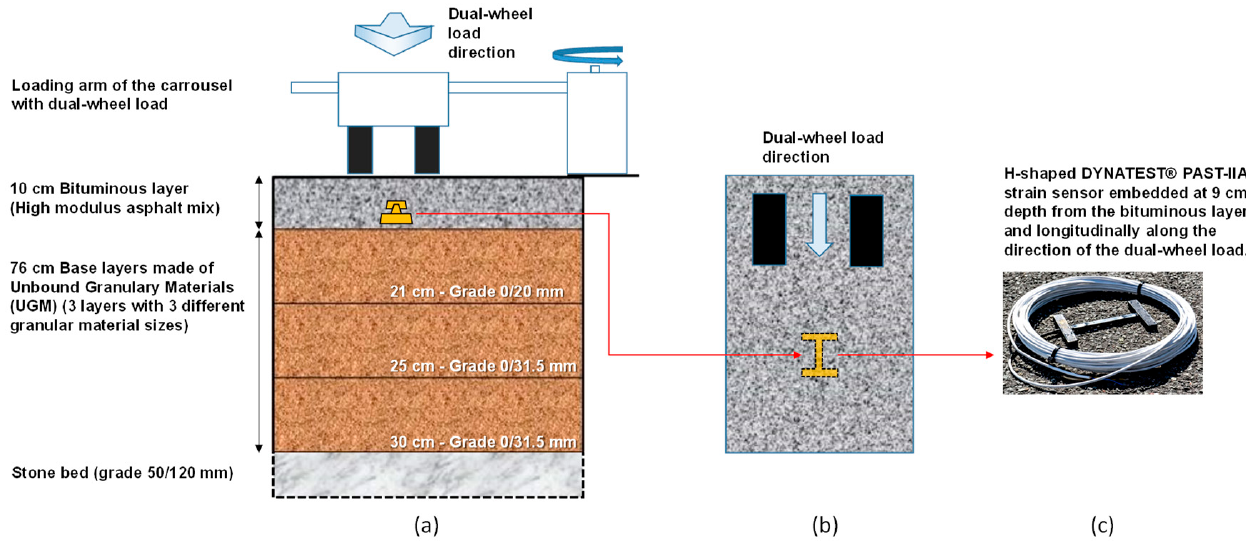
Figure 3. ( a ) Schematic representation in front view of the pavement’s structure, ( b ) top view illustrating the orientation of the strain gauge along the dual-wheel load direction, ( c ) picture of a DYNATEST ® strain gauge.